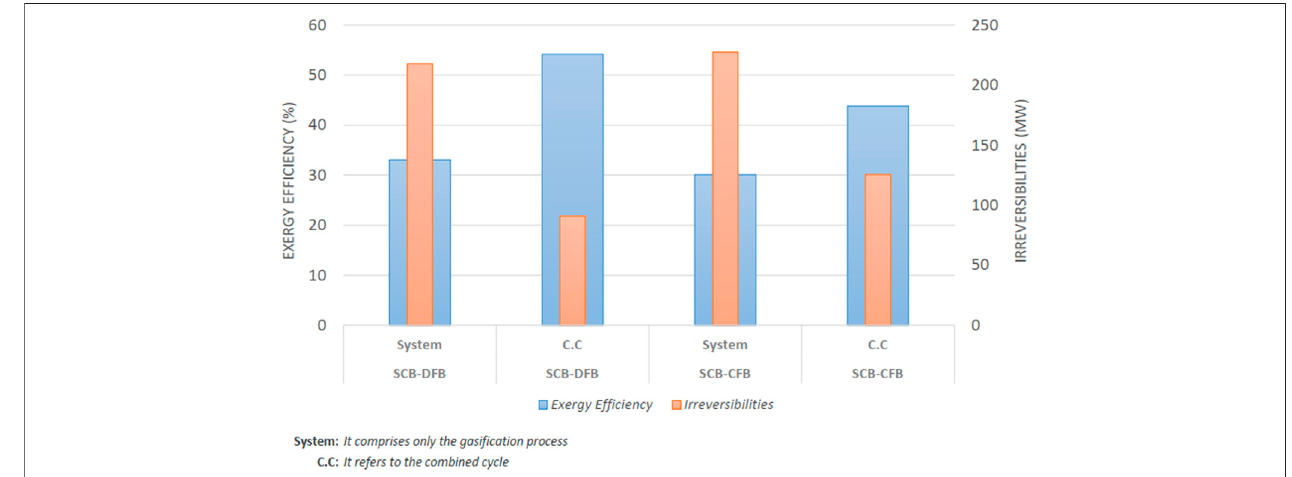
FIGURE 5 | System performance of the thermochemical routes.